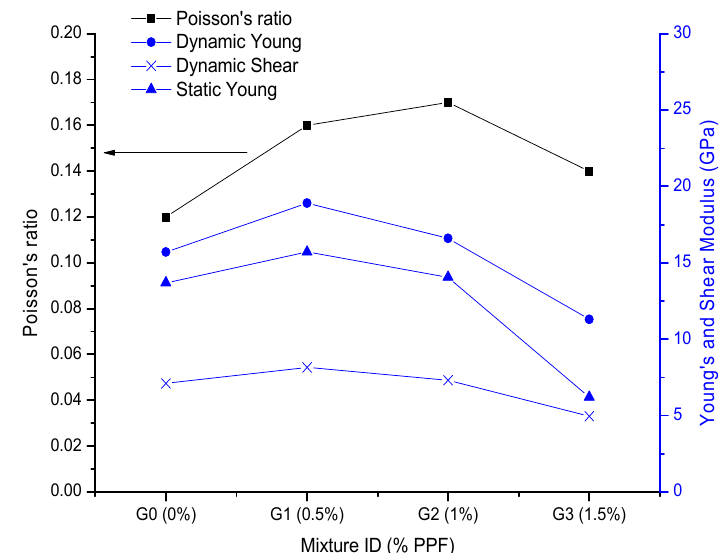
Figure 4. Elastic constants at 14 days .